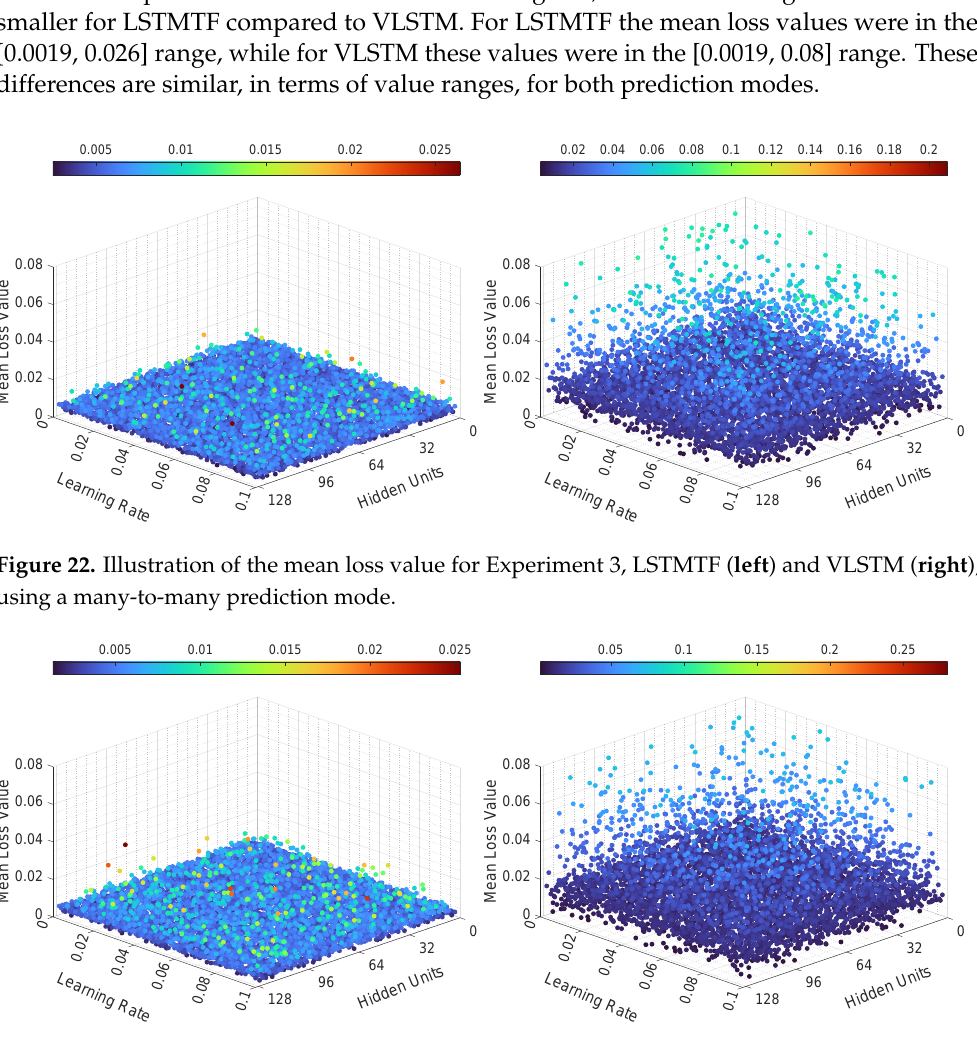
Figure 23. Illustration of the mean loss value for Experiment 3, LSTMTF ( left ) and VLSTM ( right ), using a many-to-one prediction